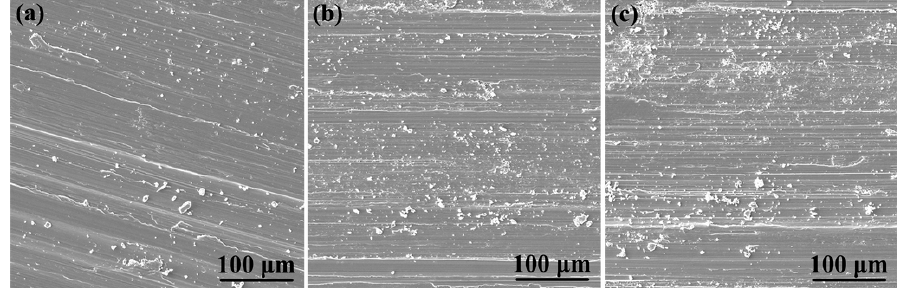
Figure 11. Worn surface morphologies of UIRP samples at 250 r/min after ( a ) 100 cycles, ( b ) 200 cycles and ( c ) 300 cycles.